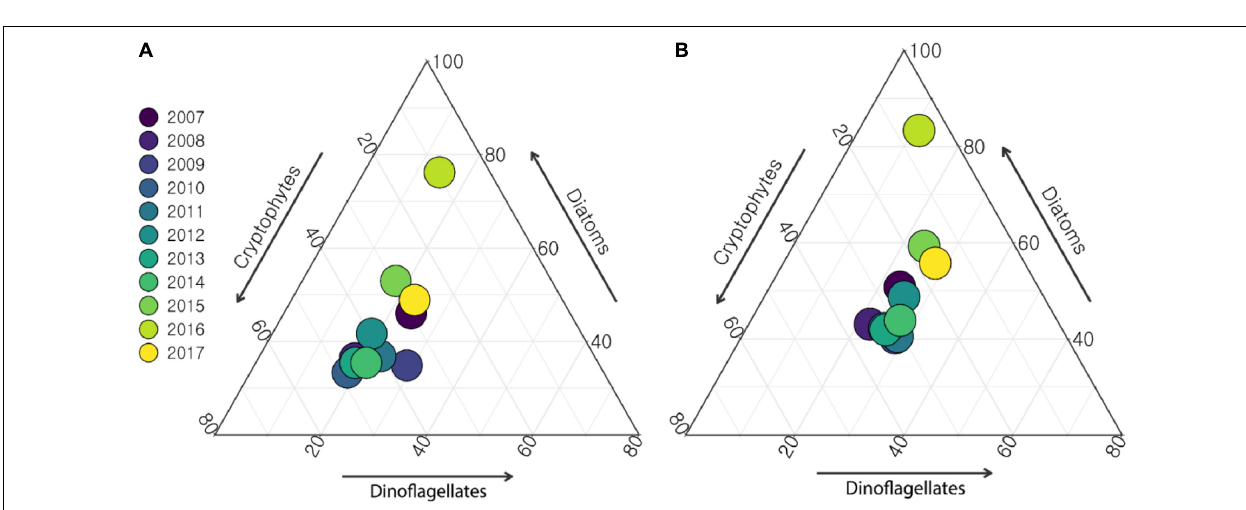
FIGURE 3 | Long-term nutrient variation in the Yeongil Bay. (A) SiO 2 , (B) NO 3 - , (C) NH 4 + , and (D) PO 43 - .